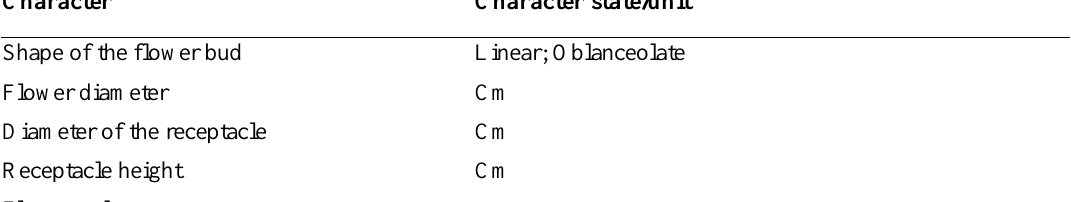
Table 1: List of characters together with their character states used in the morphometric analyses.